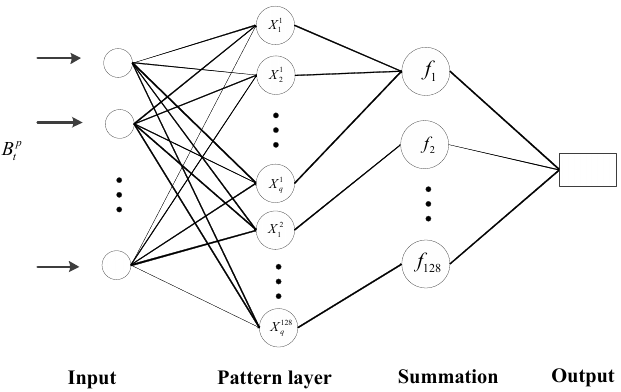
Figure 8. Probabilistic neural network structure for impact recognition.